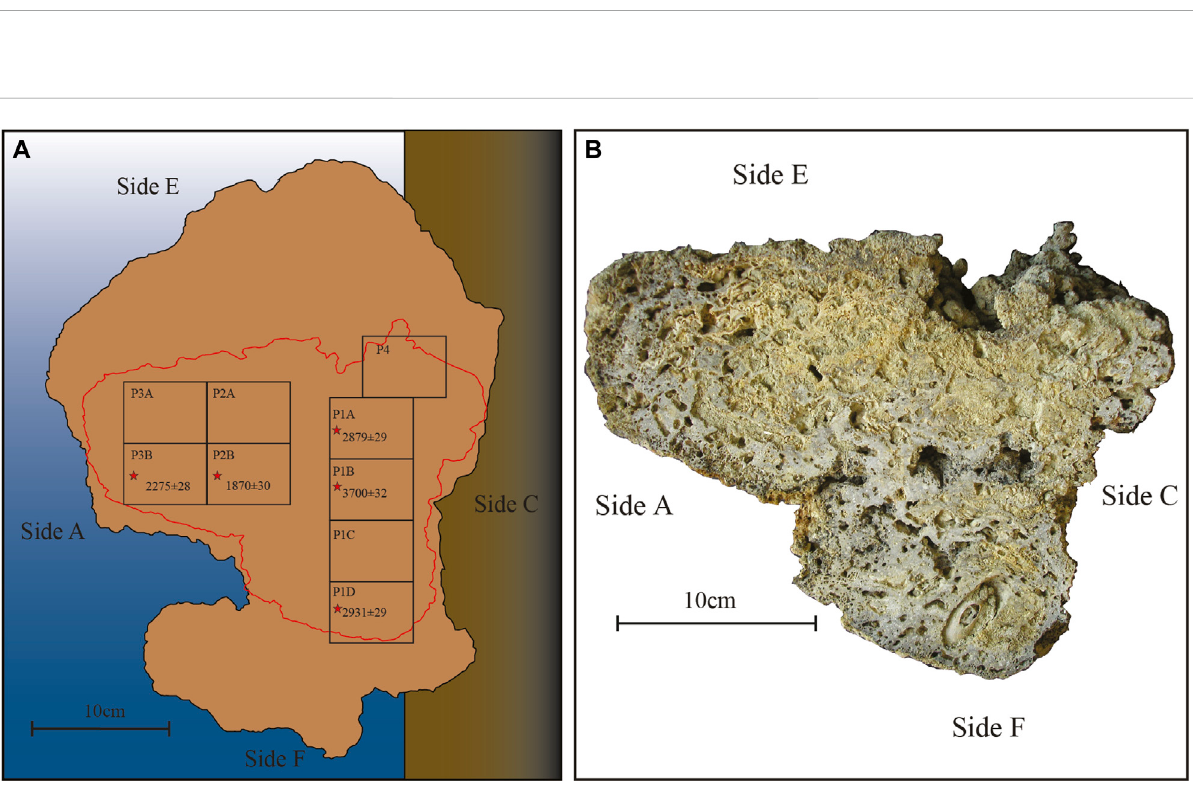
FIGURE 3 Porto fi nobuild-up. (A) Reconstructionoftheoriginalpositionwiththeindicationofthedifferentsidesindicatedbyletters.Theredlineindicates the position of the slice from which the panoramic thin sections (= numbered rectangles) have been obtained. The asterisks indicate the dated thin sectionsalongwiththeirtRCage(BP)(Table4). (B) Theslicebeforecuttingforthinsections,orientedonthebaseofthebuild-upsides.Notethelarge embedded Lithophaga shell close to side